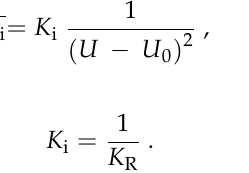
Table 4. Correlation between the mean and standard deviation of the measured t in . Experimental Condition